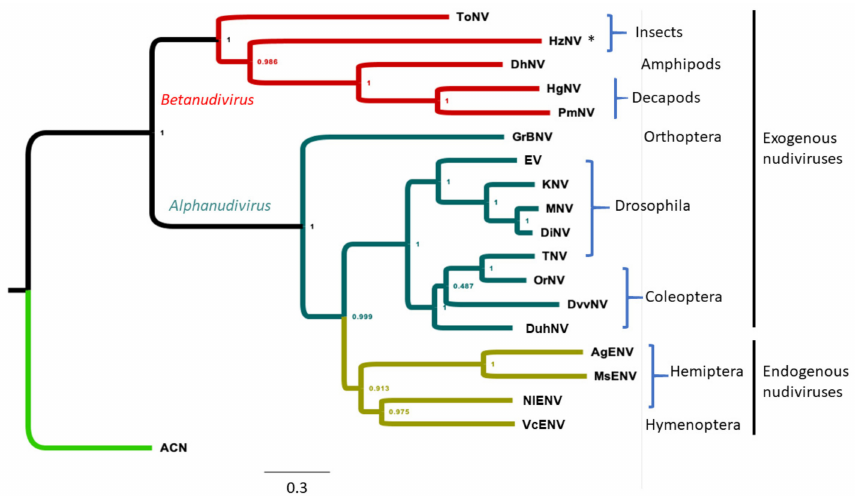
Figure 4. Phylogenetic tree based on nudivirus core sequences. Protein sequences encoded by 31 core genes were downloaded from the NCBI database for 13 sequenced nudiviruses, four endogenous nudiviruses and a baculovirus, Autographa californica nucleopolyhedrovirus (ACN, outgroup; Supple- mentary Table S3). Abbreviations for exogenous nudiviruses from Table 1. AgENV, Aphis glycines endogenous nudivirus ; MsENV, Melanaphis sacchari endogenous nudivirus ; NlENV, Nilaparvata lugens endogenous nudivirus ; VcENV, Venturia canescens endogenous nudivirus . Core sequences of AgENV